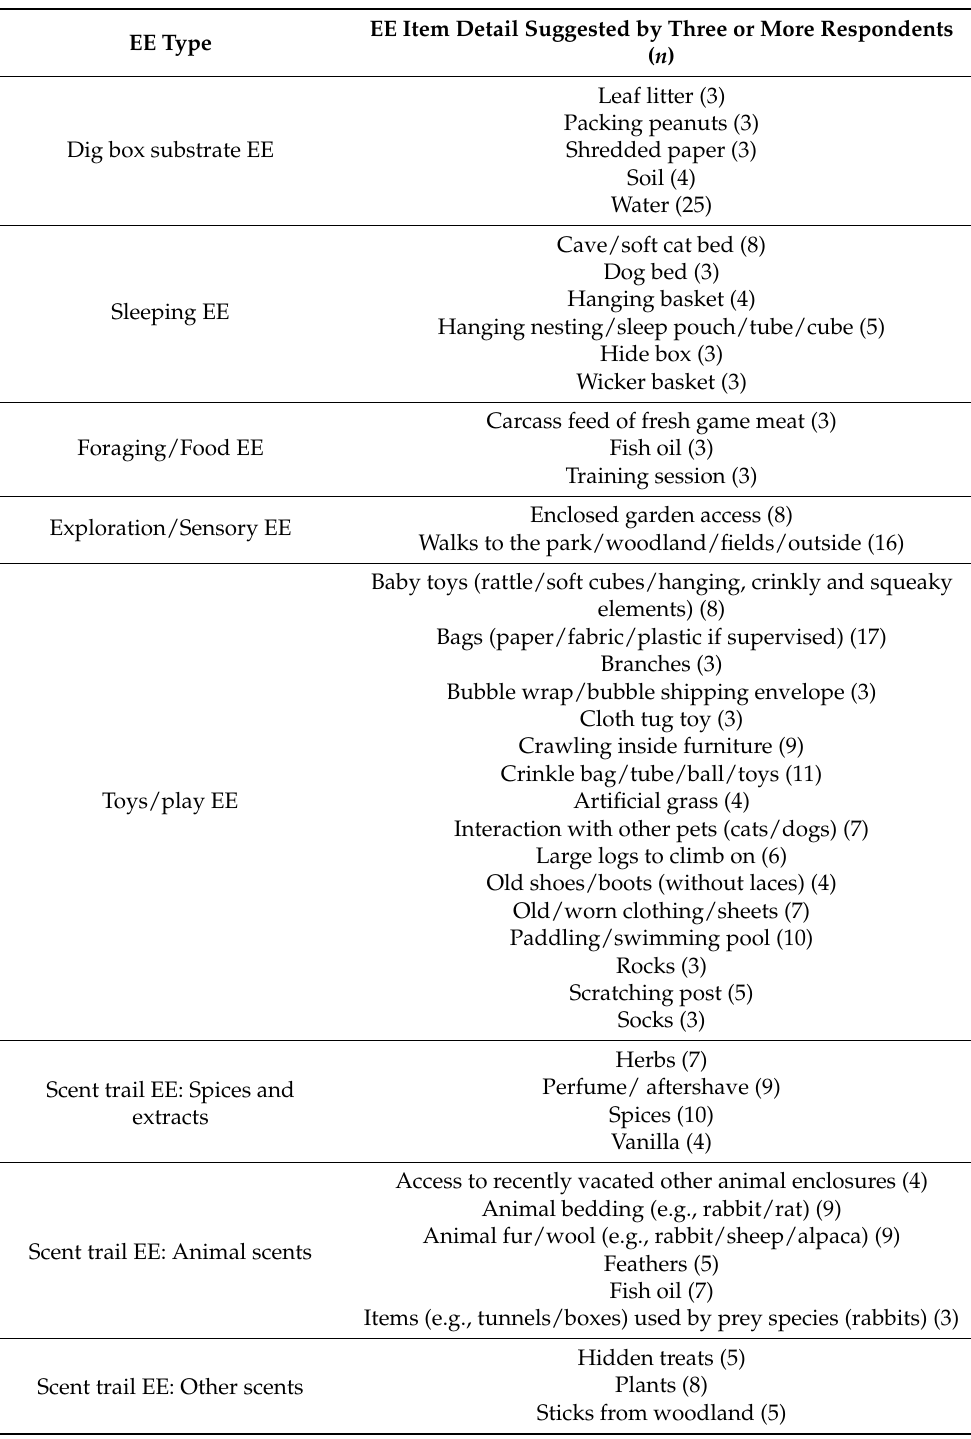
Table 4. Descriptions of EE items provided by respondents in the long answer format ‘other EE type’ answer box from across